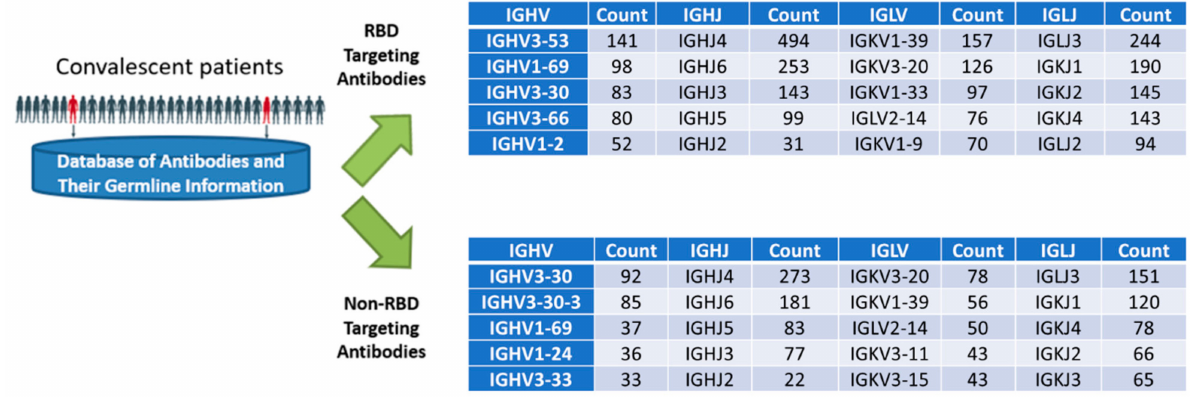
Figure 2. The distribution of heavy- and light-chain variable gene usage in 1145 RBD and 668 non-RBD antibodies isolated from convalescent patients. Antibody sequence and germline data were downloaded from CoV-AbDab